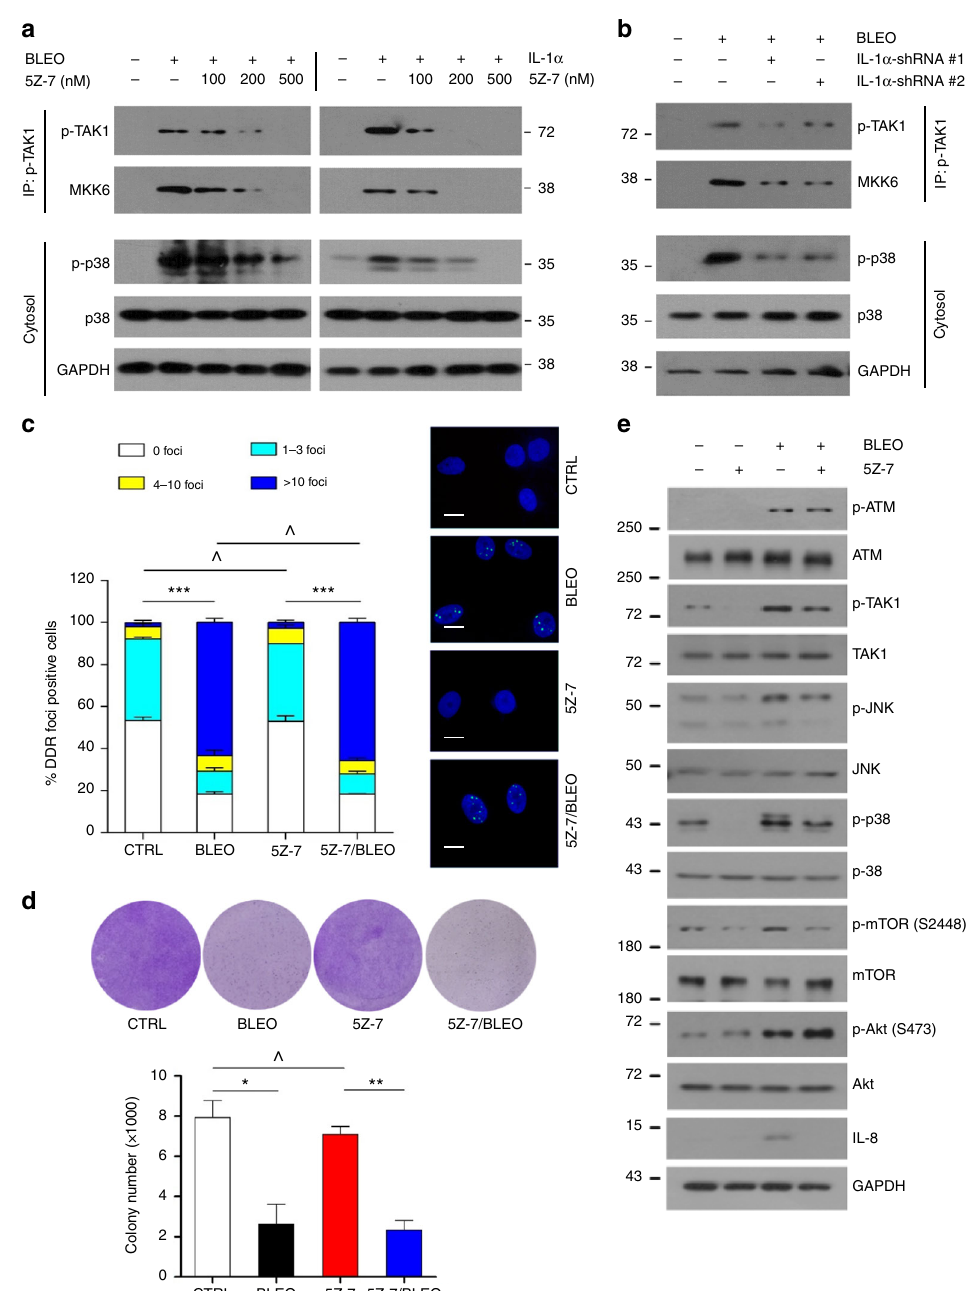
Fig. 5 TAK1 activation engages p38 but its inhibition does not in fl uence DDR signaling. a PSC27 cells were treated with bleomycin with or without increasing concentrations of the TAK1 inhibitor 5Z-7. Cell lysates were IPed with anti-p-TAK1, and subject to in vitro kinase assay with MKK6 as a substrate. Activation of kinase p38 was analyzed, with GAPDH as a loading control. Alternatively, IL-1 α (20 ng/ml) was used to stimulate cells with or without 5Z-7, with the lysates subsequently analyzed. b IL-1 α was eliminated from PSC27 cells by shRNAs. TAK1/MKK6 interaction and p38 activation in the cytosol were assessed by IP in the same conditions of a . c PSC27 cells were treated by bleomycin, or 5Z-7, or both, and subject to immuno fl uorescence (IF) staining of γ -H2AX. DNA damage extent in stromal cells was depicted as DDR statistics by counting the number of DDR foci per cell. Right, representative images of IF staining. Green, γ -H2AX; Blue, DAPI. Scale bars, 10 μ m. Data analyzed by two-way ANOVA. d Top, representative images for clonogenic assay. PSC27 cells were treated by bleomycin alone for 6 h then released until 7d later, or treated by 5Z-7 alone continuously for 7d, or treated by both agents for individual time length in culture, after which clonogenic staining was performed. Bottom, statistics of stromal cell clonogenic growth. Data analyzed by Student ’ s t -test. e PSC27 cells were treated with bleomycin and/or 5Z-7, and cell lysates were collected 7d after drug treatment for immunoblot analysis. JNK1 phosphorylation and IL-8 expression were used to probe TAK1 activation and SASP development, respectively. Activation of mTOR and Akt were assayed with the same set of lysates, as well. Data in all bar plots are shown as mean ± SD. All data are representative of 3 biological replicates. * P < 0.05, ** P < 0.01, *** P <